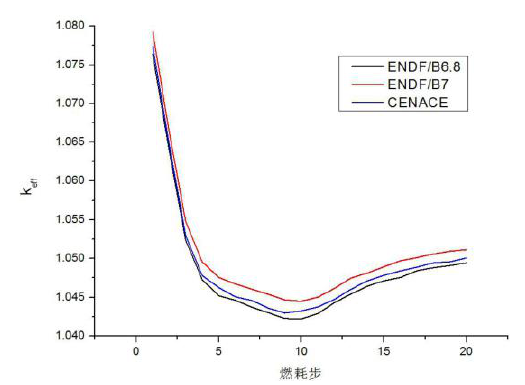
Fig.6. Results of AFA3G31016 assemble in first 20 steps